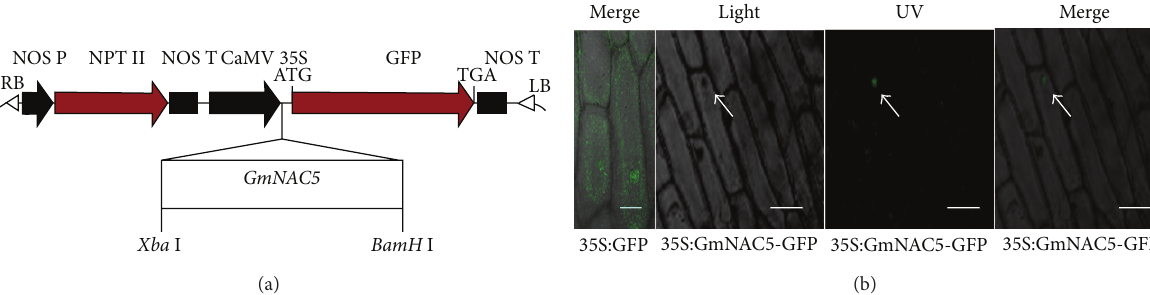
Figure 2: Subcellular localization of GmNAC5. (a) The structure of 35S:GmNAC5-GFP vector. (b) Subcellular localization of GmNAC5-GFP fusion protein. The arrow indicates the location of the nucleus. Bars: 40 𝜇 m in 35S:GFP; 80 𝜇 m in 35S:GmNAC5-GFP.